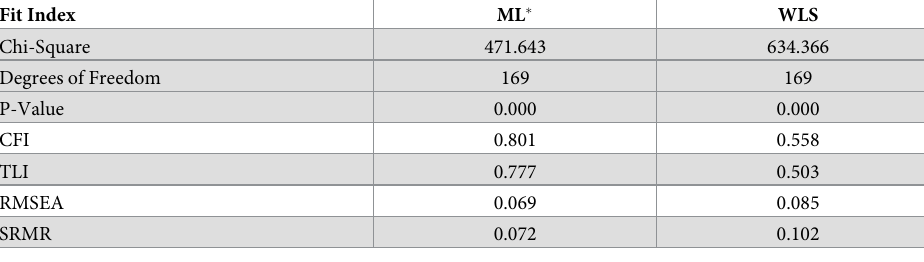
Table 8. Fit indices for the R-SPQ-2F